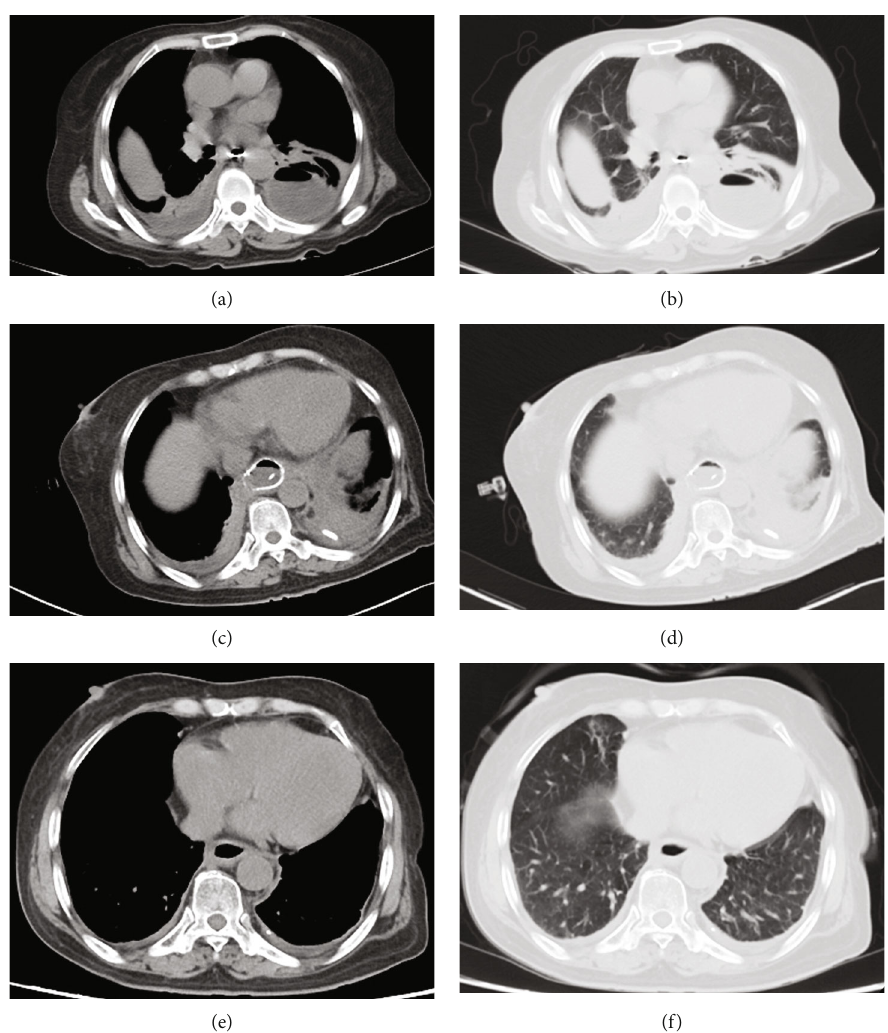
Figure 1: Chest computed tomography for case 16. (a, b) Chest CT scan in the mediastinal and lung windows shows anastomotic leakage, atelectasis, and bilateral pleural e ff usion before interventional procedure. (c, d) At one month after three-tube treatment and covered stent placement, a chest CT scan shows a covered stent with decreased pleural e ff usion. (e, f) After removal of three-tube and covered stent, a chest CT scan shows disappearance of abscess, expansion of the lungs with no pleural e ff